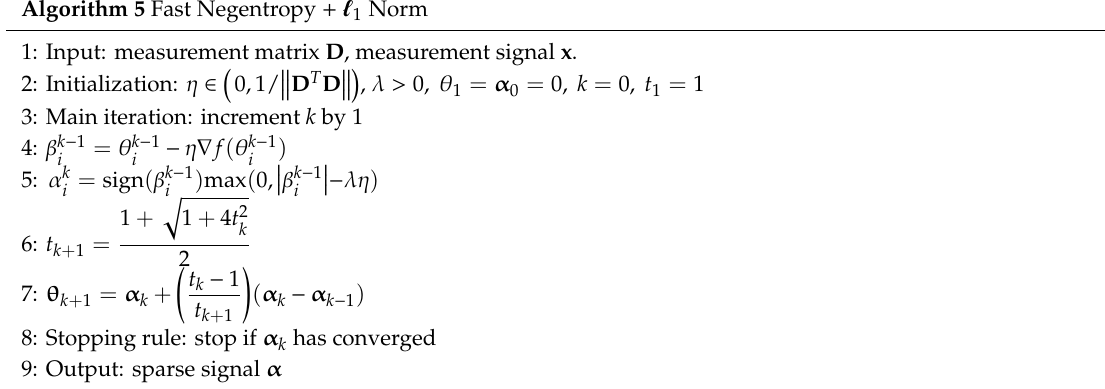
Algorithm 5 Fast Negentropy + (cid:96) 1